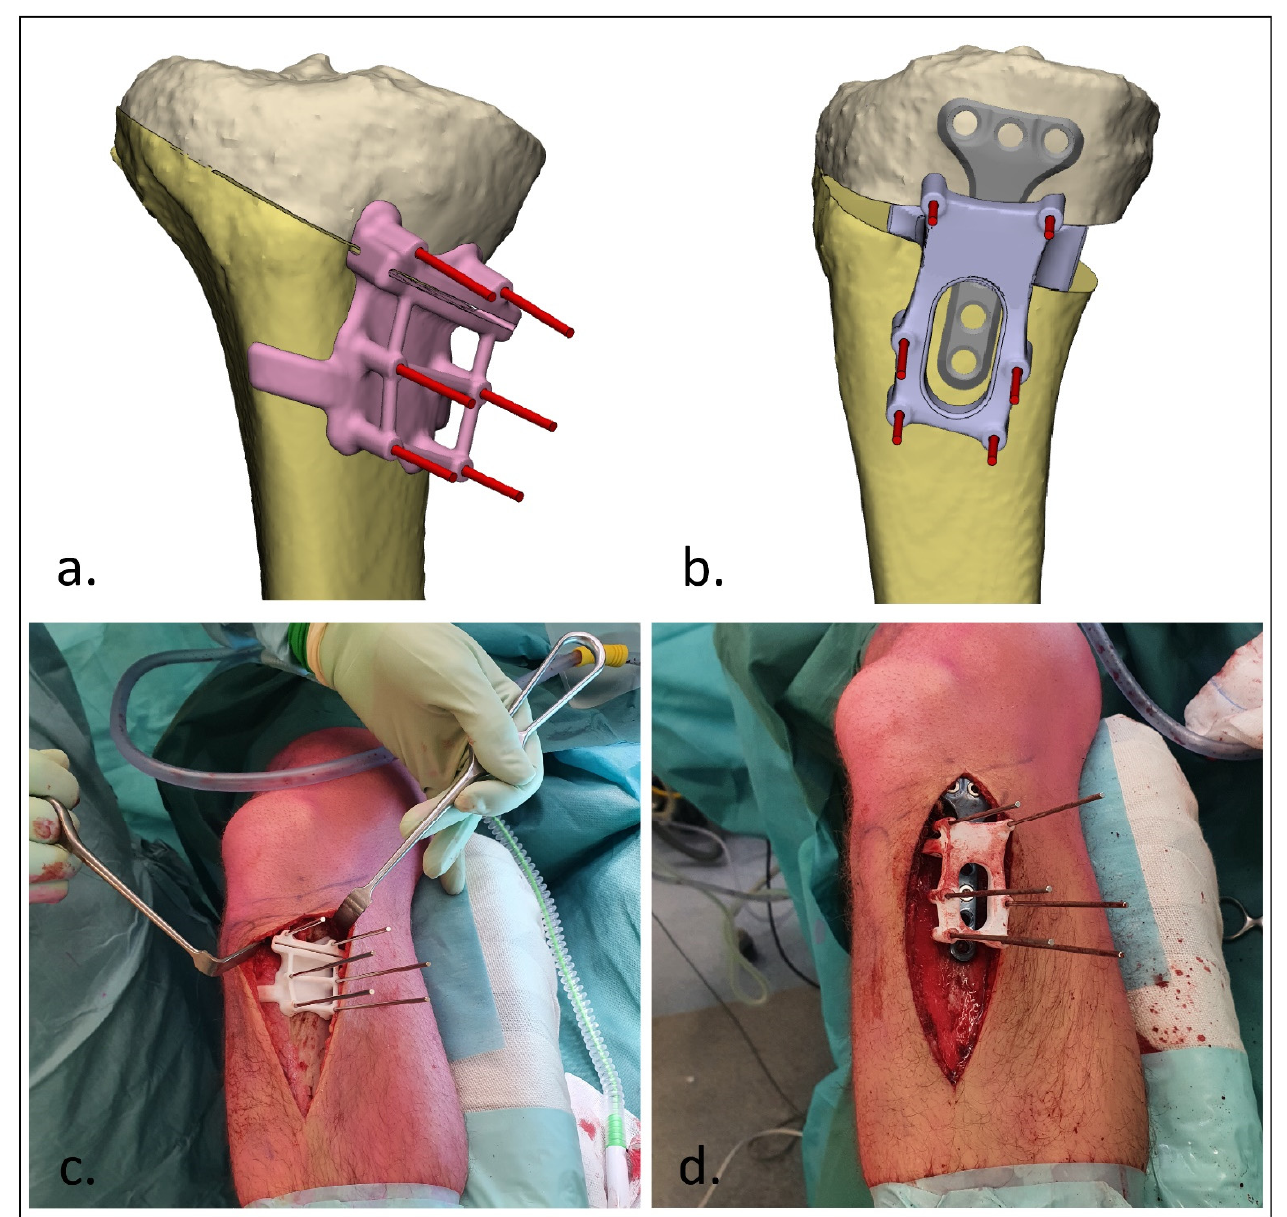
Figure 3. 3D-guided patient-specific corrective osteotomy of a proximal tibia (Case 8). ( a ) Frontal view of the designed cutting guide (pink) with the K-wires; ( b ) lateral view of the designed reposition guide (purple) with the parallel K-wires and insertion of the planned wedge; ( c ) operative usage of the cutting guide; ( d ) operative usage of the reposition guide.